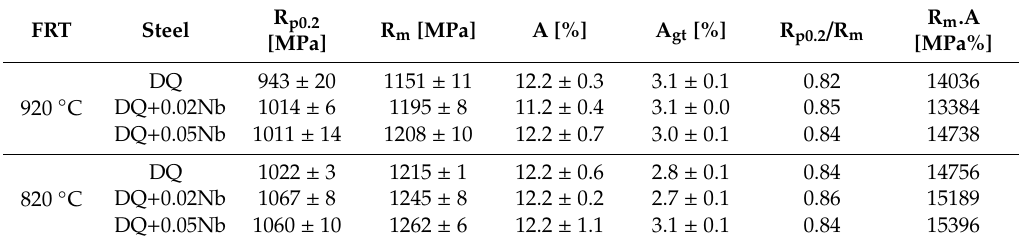
Figure13. Lowangle(2.5–15 ◦ , redlines)andhighangle( > 15 ◦ , blacklines)boundariesoftheinvestigated steels; upper row: FRT 920 ◦ C, lower row: FRT 820 ◦ C. ( a , d ) DQ, ( b , e ) DQ + 0.02Nb, ( c , f ) DQ + 0.05Nb. Table 6. Tensile properties of the investigated